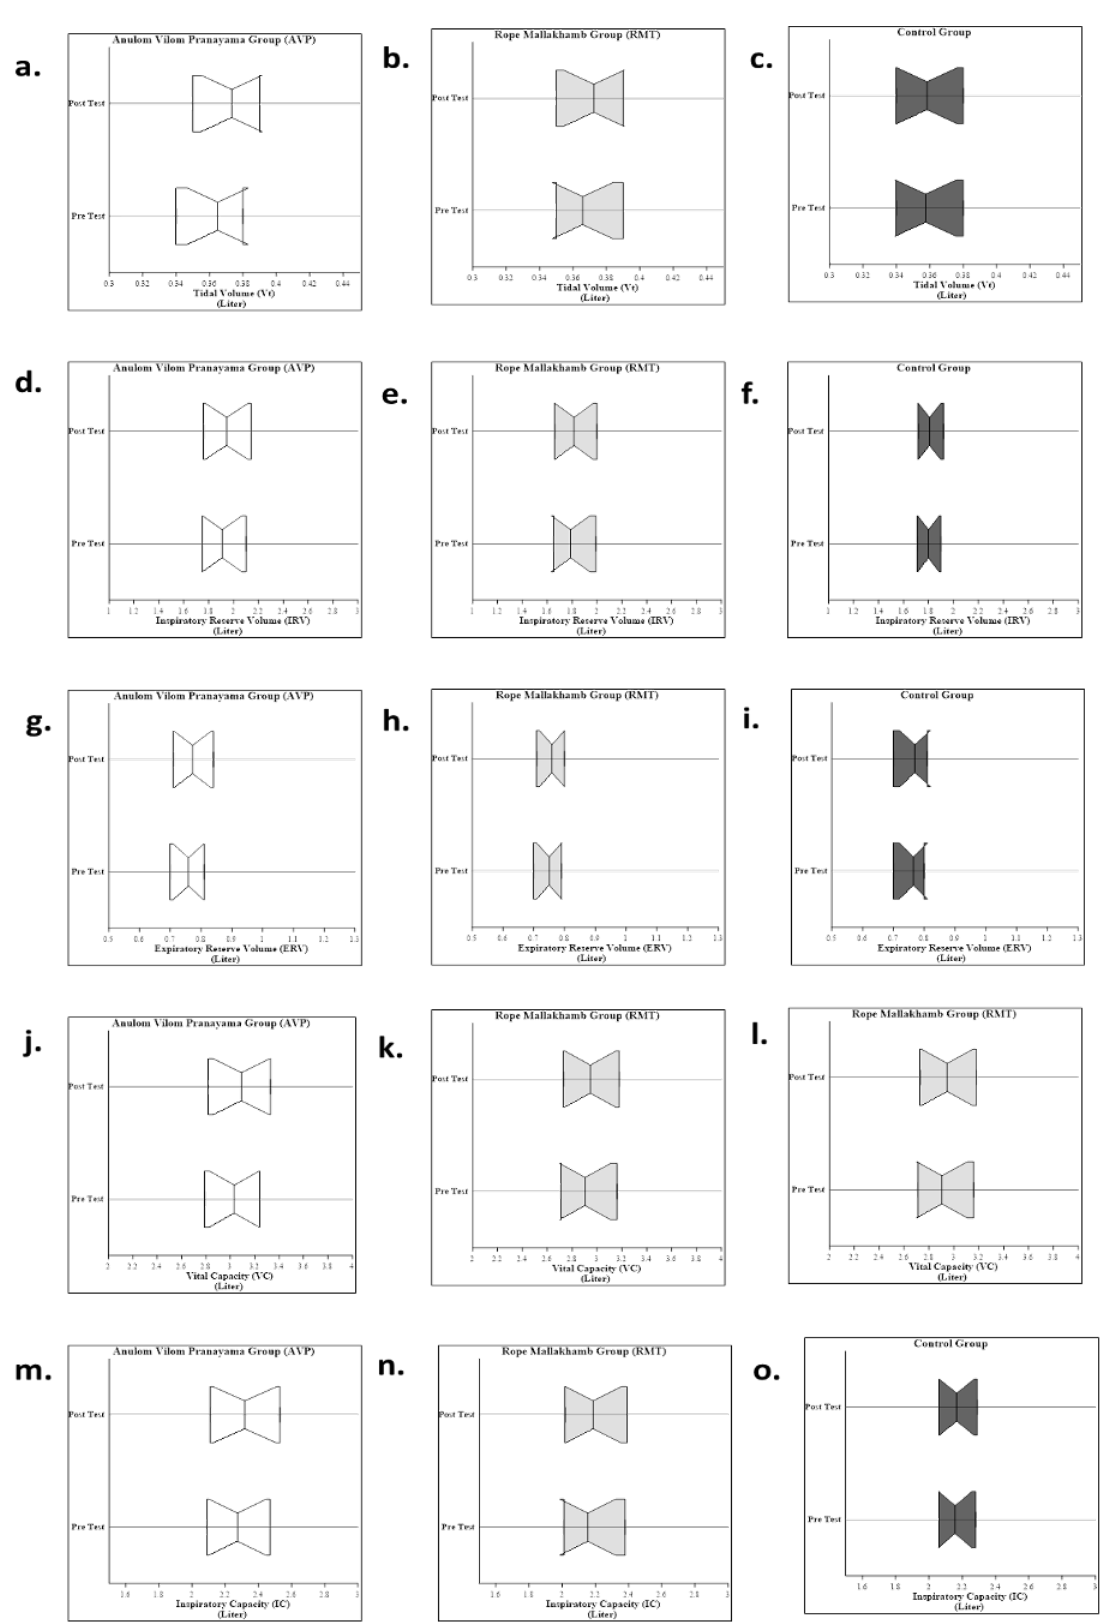
Figure 5. Mean Scores Across the 4-weeks Intervention Period (a) VT; Anulom Vilom Group, (b) VT; Rope Mallakhamb Group, (c) VT; Control Group, (d) IRV; Anulom Vilom Group, (e) IRV; Rope Mallakhamb Group, (f) IRV; Control Group, (g) ERV; Anulom Vilom Group, (h) ERV; Rope Mallakhamb Group, (i) ERV; Control Group, (j) VC; Anulom Vilom Group, (k) VC; Rope Mallakhamb Group, (l) VC; Control Group, (m) IC; Anulom Vilom, (n) IC; Rope Mallakhamb Group, and (o) IC; Control